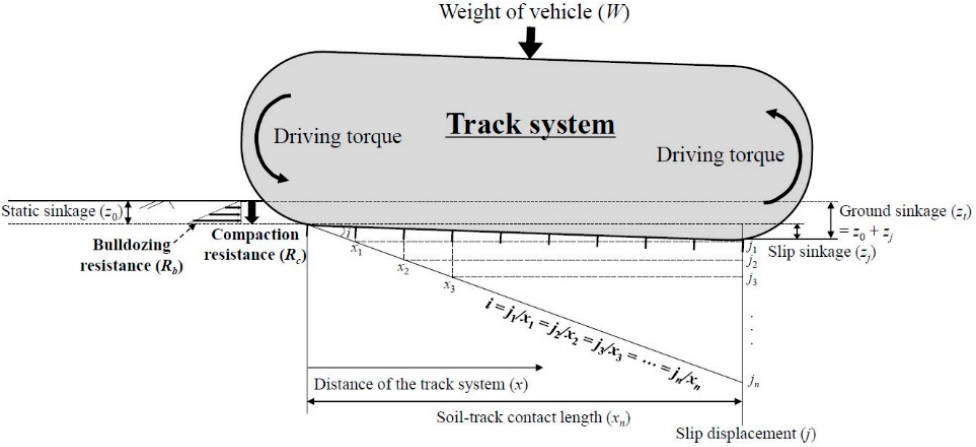
Figure 1. Schematic diagram of the ground deformation (settlement and slip displacement) and motion resistances.